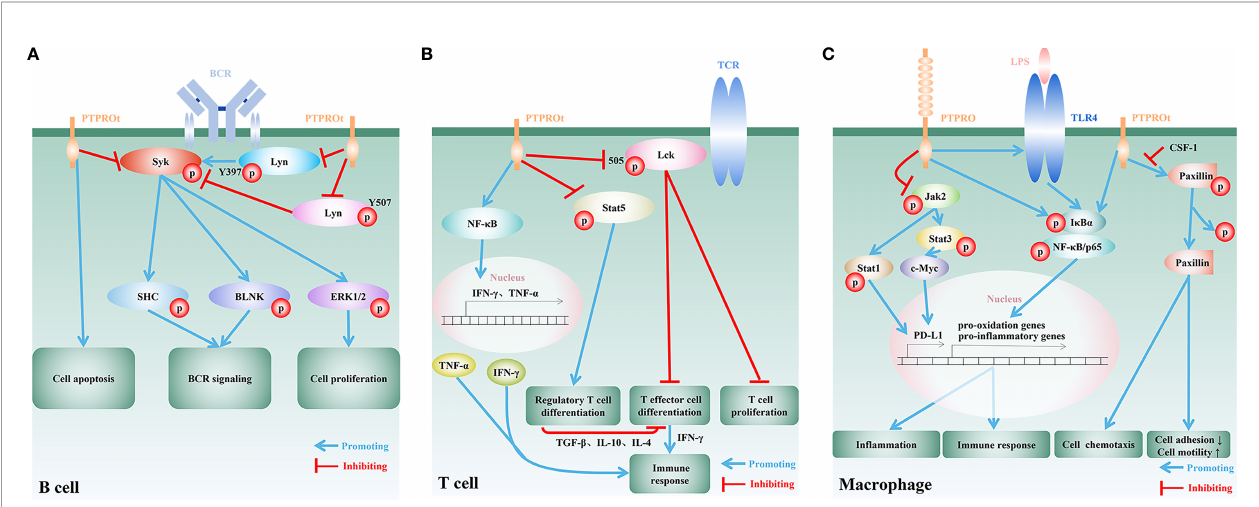
FIGURE 1 | Regulatory functions and mechanisms of PTPRO/PTPROt in immune cells. (A) In B cells, PTPROt induces apoptosis and negatively regulates BCR signal cascade ampli fi cation via dephosphorylating BCR-triggered Syk and Lyn at its active tyrosine phosphorylation site (Y397). Activation of the associated adaptor proteins SHC and BLNK, and downstream signaling events, including MAPK/ERK activation, are blocked by PTPROt, leading to the inhibition of B lymphocyte proliferation. PTPROt can also dephosphorylate Lyn at its inhibitory tyrosine phosphorylation site (Y507) and TCR-associated tyrosine kinase ZAP70 anomalously expressed in human primary chronic lymphocytic leukemia (B-CLL). (B) In T cells, PTPROt is mainly responsible for the inhibition of inactive Lck with Y505 phosphorylated, and thus enhances TCR signaling as well as its downstream events, including T cell proliferation and T effector cell differentiation. T effector cells boost immune response via the secretion of IFN- g . PTPROt can also motivate NF- k B signaling pathways, which facilitate the production of pro-in fl ammatory factors, IFN- g and TNF- a , and subsequently enhance immunity. On the other hand, PTPROt inhibits the phosphorylation of Stat5 and blocks its promotion on the differentiation of regulatory T cell. The latter negatively regulates immune response by suppressing T effector cell differentiation through secreting inhibitory TGF- b , IL- 10 and IL-4. (C) PTPROt can promote the motility of macrophages but inhibit adhesion via promoting phosphorylated paxillin dephosphorylation, which can be blocked by CSF-1. In an in fl ammatory environment, such as LPS stimulation, NF- k B signaling pathways are motivated by PTPRO/PTPROt with increased phosphorylated I k B a and p65, which induce the expression of pro-oxidation and pro-in fl ammatory genes and thus aggravate in fl ammation and promote immune response. PTPRO can also block Jak2/Stat1 and Jak2/Stat3/c-Myc pathways so as to enhance immunity via reducing the expression of PD-L1.